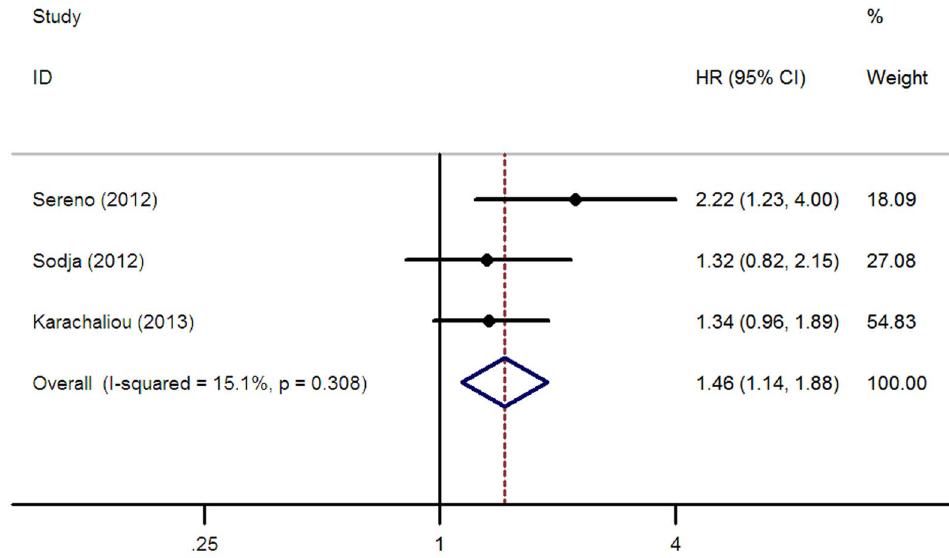
Figure 5. Forest plot for the association between ERCC1 level and progression free survival (PFS) in SCLC patients receiving platinum-based chemotherapy.